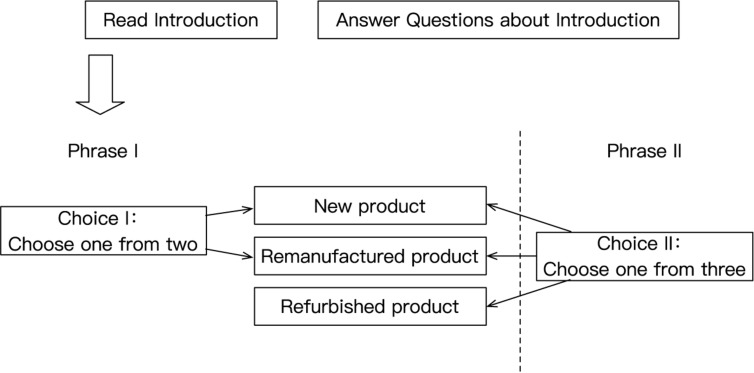
Experimental flow.